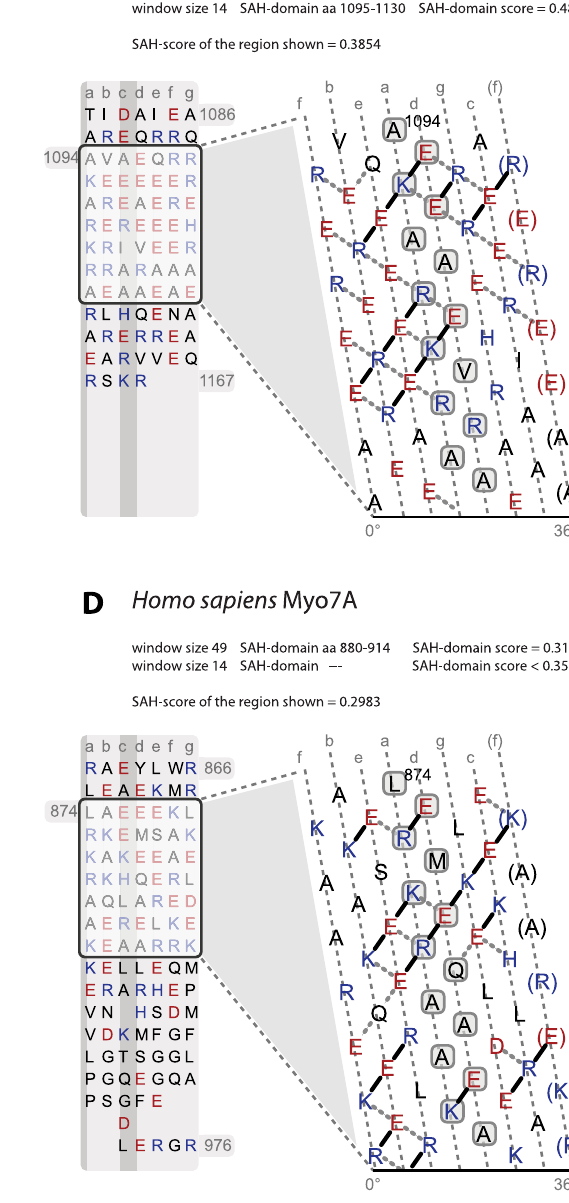
Fig 5. Examples of SAH-domains, and regions probably not containing SAH-domains. A) SAH-domain of Acanthamoeba healyi Myo22C, which is among the SAH-domains with the highestSAH-domain-scores. B) Example for a short SAH-domain, which is only detected with the 14, 21, and 28 amino acid windowsizes for computingSAH-scores. This short SAH-domain is located C-terminal to the class-1 myosin-specific MyTH1 domain and therefore not part of the lever. Its putative function is to spatially separatethe MyTH1 domain from another small domainor protein interaction motif of unknownfunction at the C-terminus. C) Examplefor a short SAH-domain with a SAH-domain-scorein the twilight zone. This highly chargedregionis uniqueto mammalian Mhc14 class-2 myosins (MYH7B, myosin cardiac muscle beta chain; S6 Fig) and interrupts the long coiled-coil filament-forming regionof the muscle myosins. The subsequent C-terminal sequencecontainsa large numberof amino acids with high helix-breaking propensity such as glycinesand serines. The putative function of the short SAH-domain and the followingglycine-rich regionmight be to openup the coiled-coil.D) Exampleof a regionrich in chargedamino acids but with an SAH-domain-score in the range of non-SAH-domains.